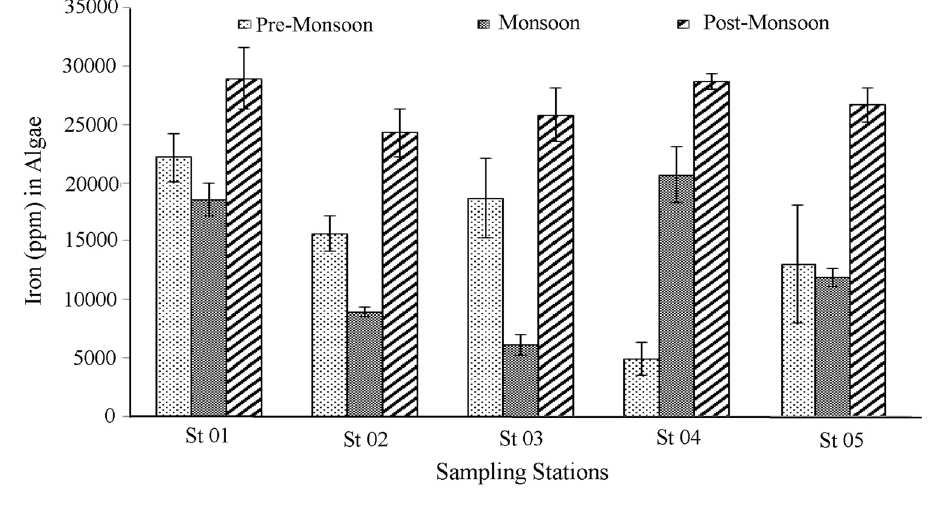
Fig. 10 Algal zinc concentra- tion (± SD) variation at different seasons in different stations of Sundarban mangrove